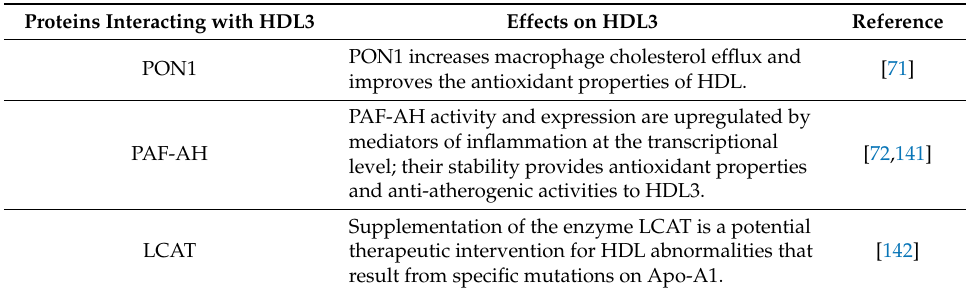
Table 2. Proteins associated with HDL3. PAF-AH = platelet-activating factor